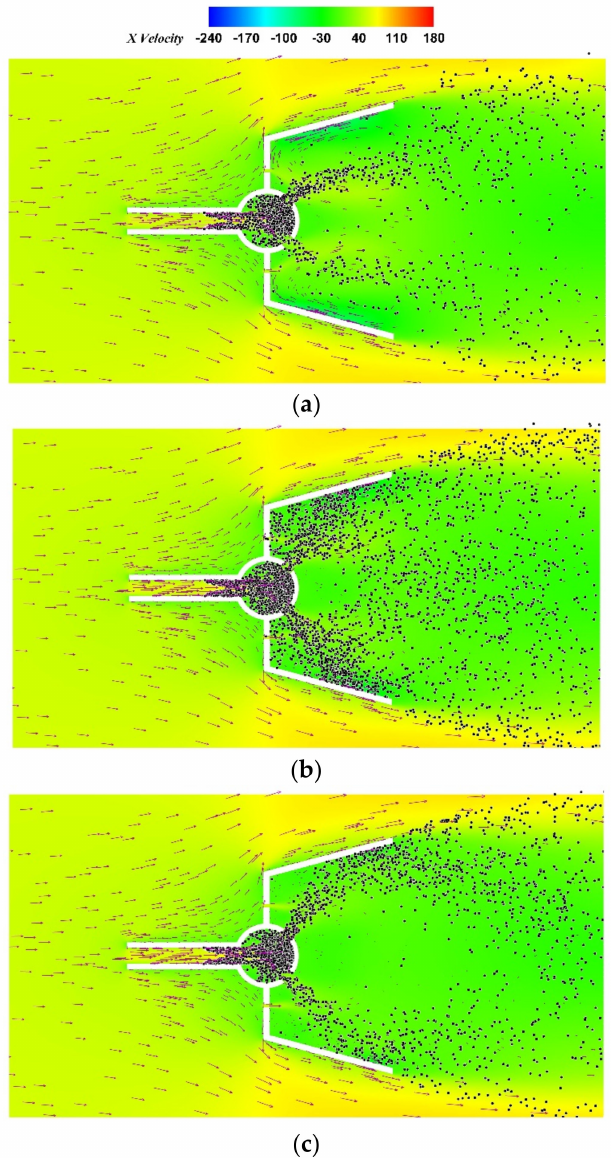
Figure 11. Spray field at different actuation dimensions: ( a ) 20 mm, ( b ) 10 mm, ( c ) 5 mm with 5 kV and 14